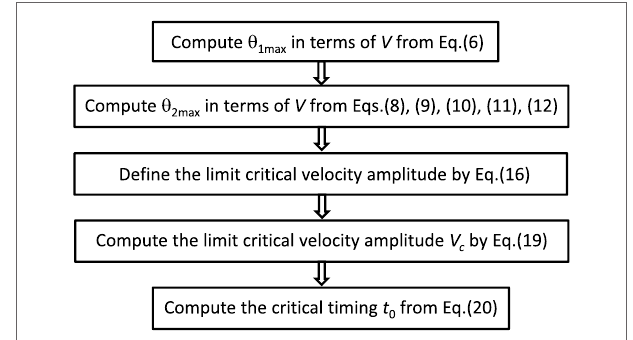
FigUre 7 | Flowchart for finding critical velocity amplitude of double impulse .